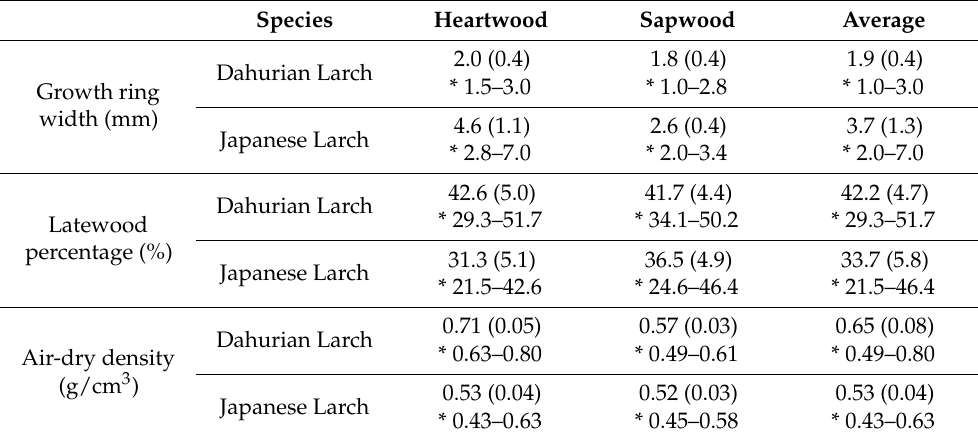
Table 3. Physical properties of Dahurian larch and Japanese larch. Species Heartwood